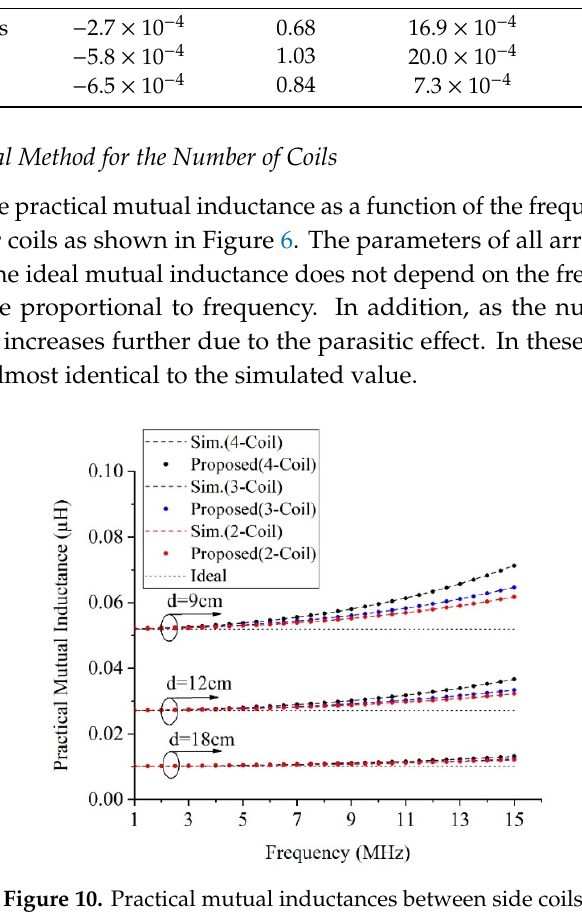
( b ) Figure 11. Normalized transfer impedance in the array of four coils: ( a ) One-hop; and ( b ) two-hop routes. Finally, for four coils, the practical mutual inductances by all routes and the routes except two more hopping routes with respect to the frequency are as shown in Figure 12. Even if the two-hop routes are not taken into account, the calculated mutual inductances are in good agreement with the results of all the routes as well as the simulated results.